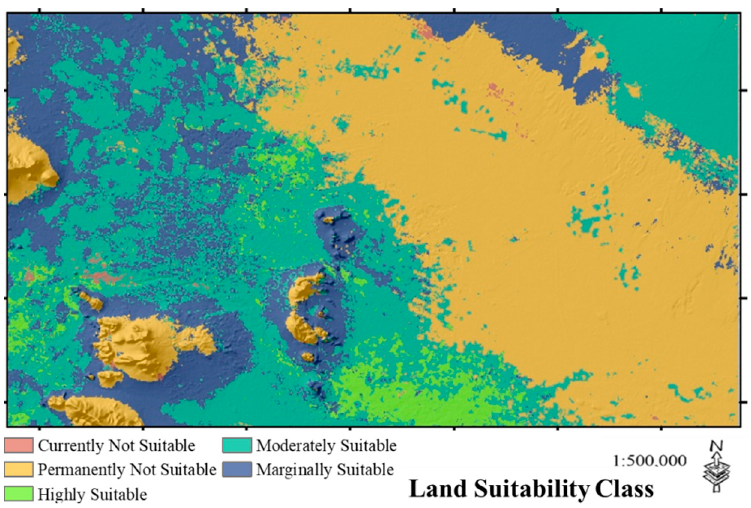
Figure 6. Spatial distribution of land suitability classes for irrigated wheat.